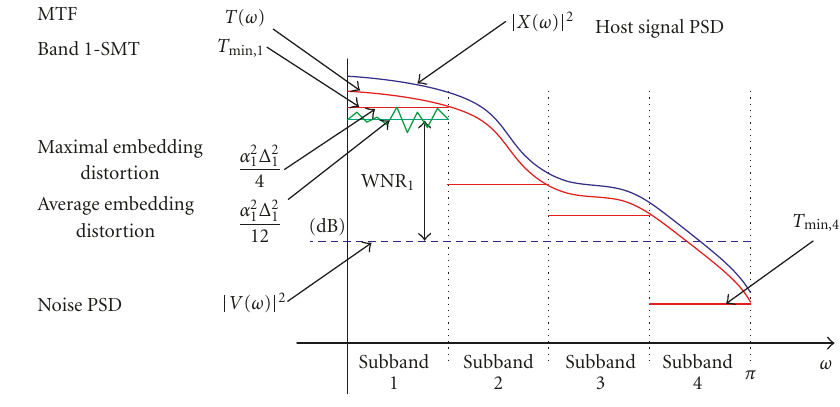
Figure 6: A schematic drawing of a speech signal power spectral density (PSD) estimate, | X ( ω ) | 2 , divided into 4 subbands; MTF— T ( ω ); the SMTs— T min, m , are marked by the horizontal solid lines. AWGN source power spectral density (PSD) estimate | V ( ω ) | 2 is marked by the dashed line. The WNR in the first subband (WNR 1 ) is also